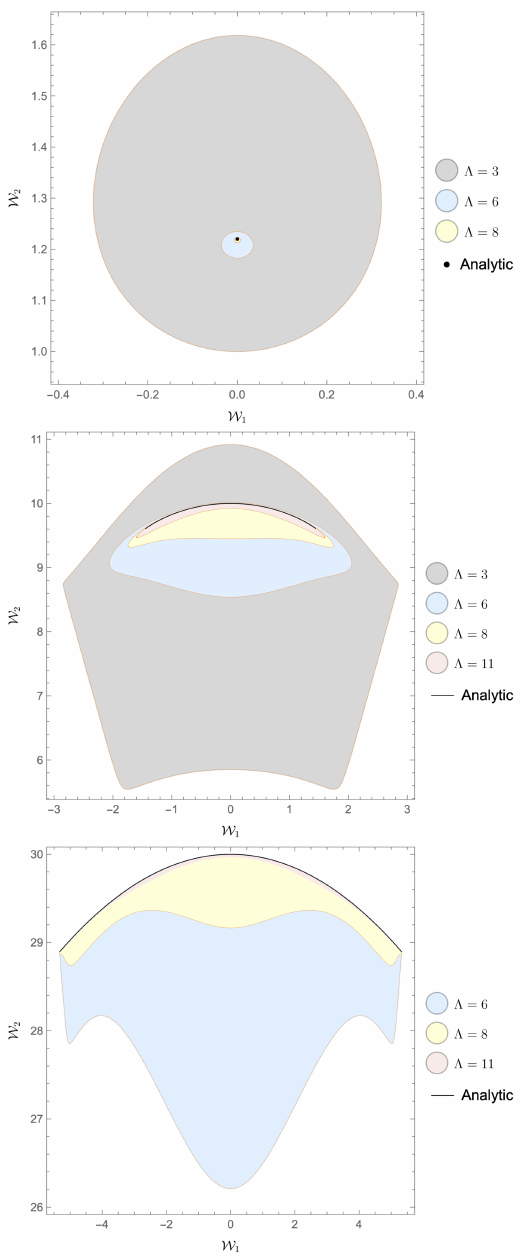
Figure 3 . The comparison of numerical bootstrap with our analytic bootstrap results (the black point or the black curve on the figures) in section 3.2 with µ = − 1 in potential (3.6). They are representatives from different phases of the model, with g = 1 , 1 to below, respectively). We notice even visually that for g < 1 exact solution is a non-convex